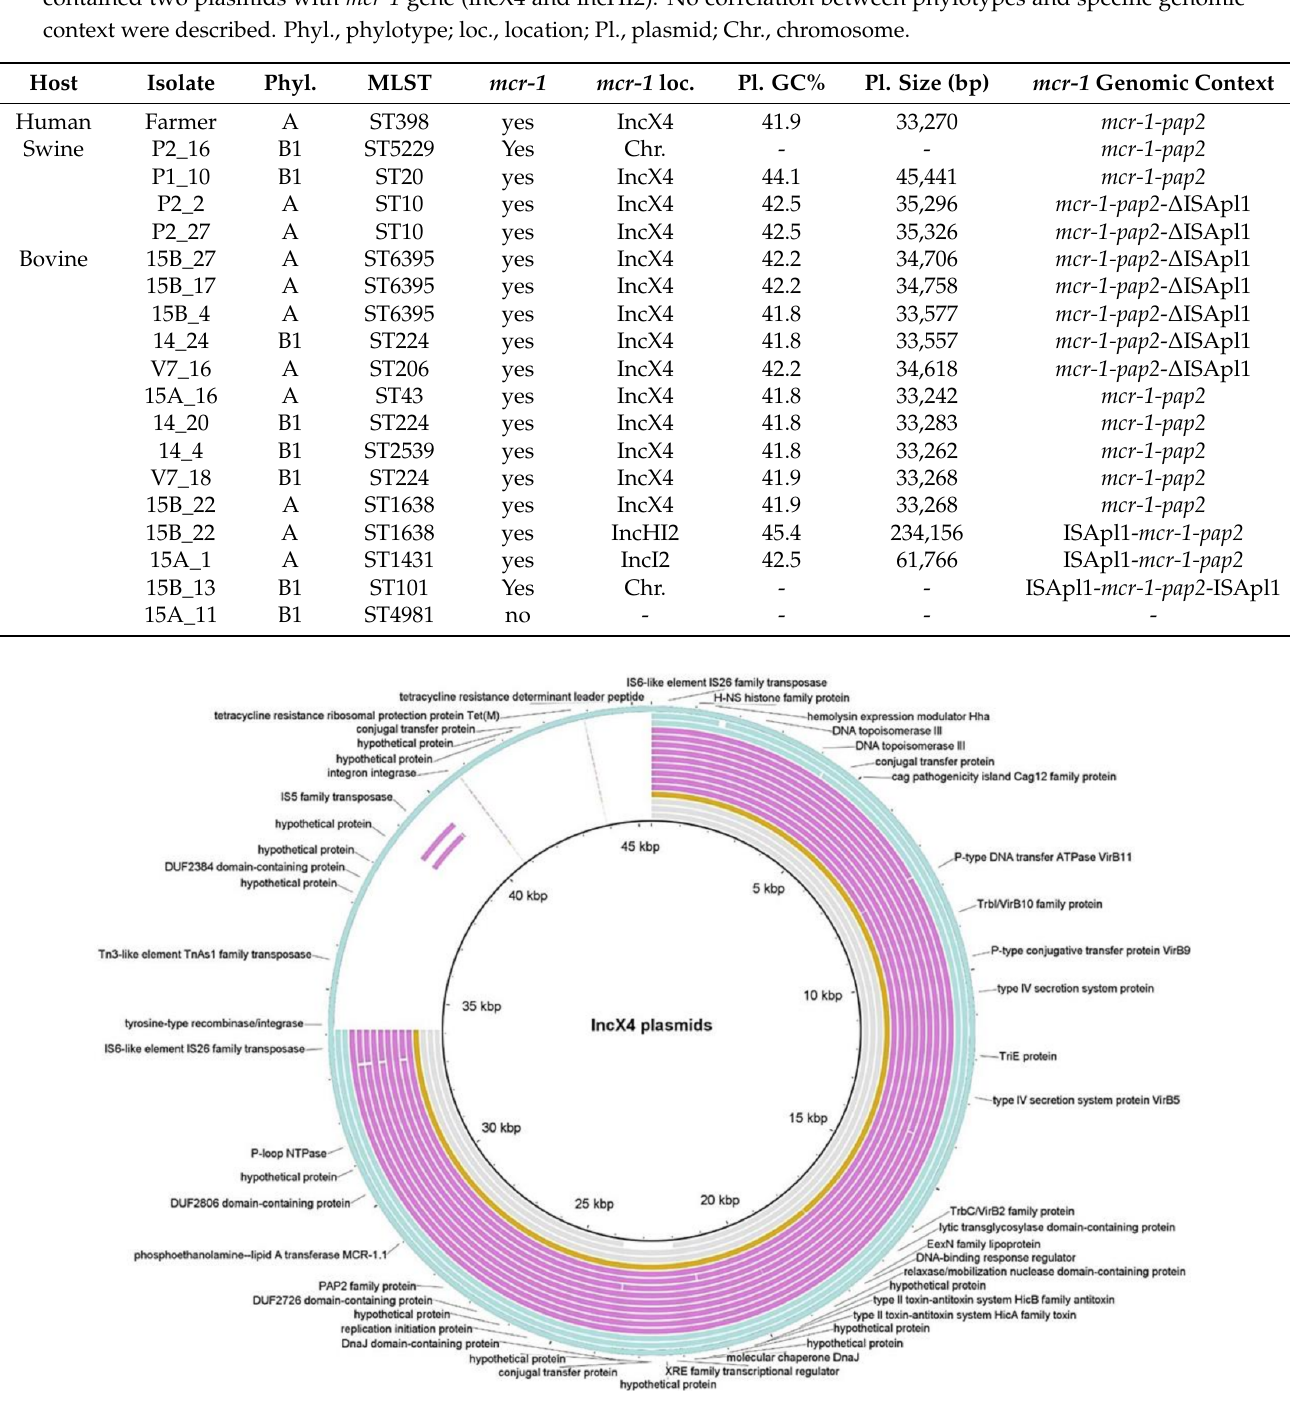
Table 1. Location and genomic context of mcr-1 gene. mcr-1 gene was found in 17 out of the 18 colistin resistant E. coli isolates either in a plasmid (14 in IncX4, one in IncI2, and one in IncHI2 replicons), or the chromosome. Isolate 15B_22 contained two plasmids with mcr-1 gene (lncX4 and lncHI2). No correlation between phylotypes and specific genomic